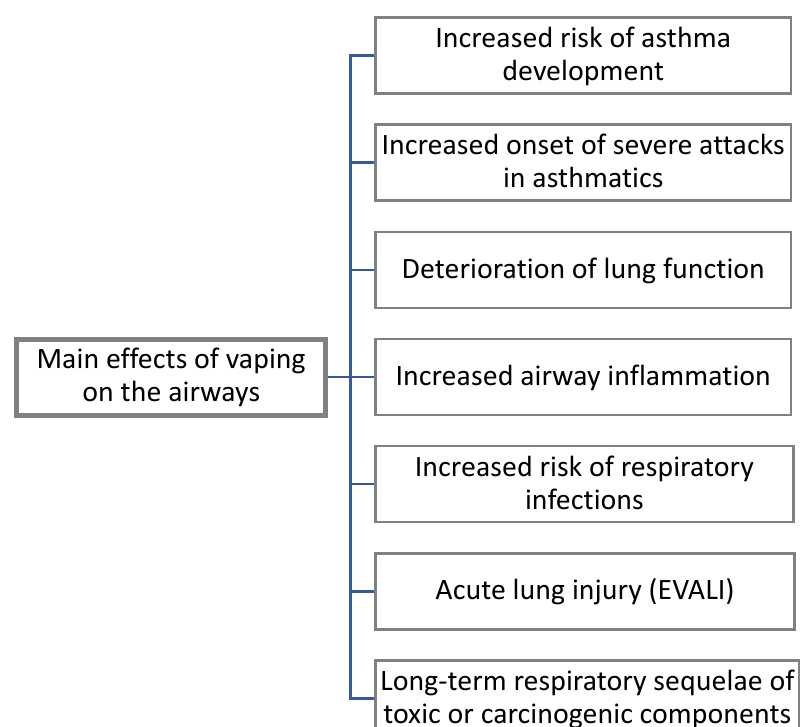
Figure 1. Evidenced effects of vaping on the airways.